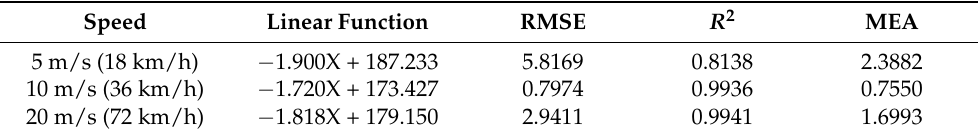
Table 5. The effect of a drone’s speed on the performance; the results are presented for location #1 and an altitude of 100 m, at various speeds.